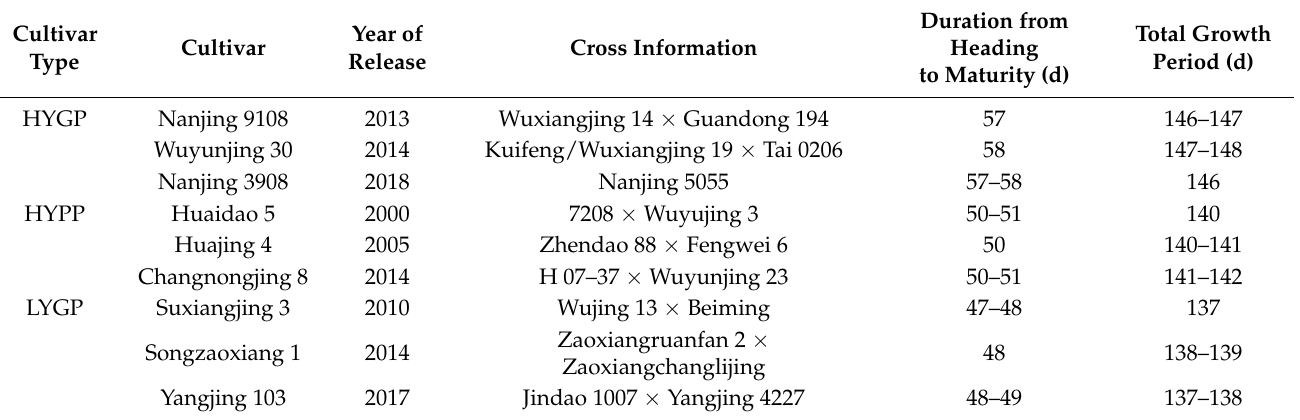
Table 1. The specific information about the year of release, cross information, and growth period of rice cultivars.